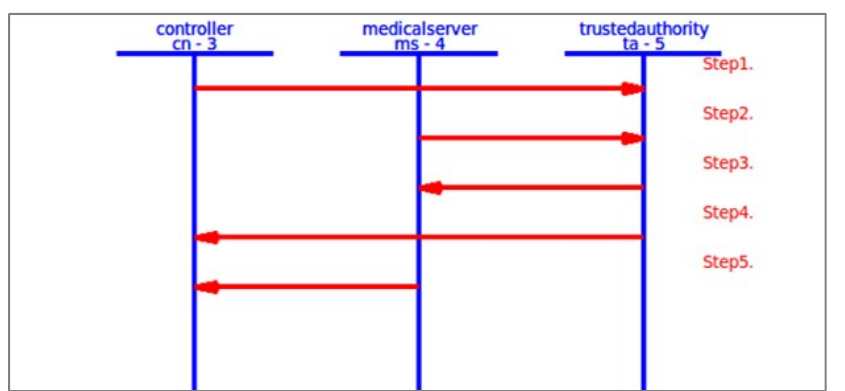
Figure 12. The SPAN animator of P-II.